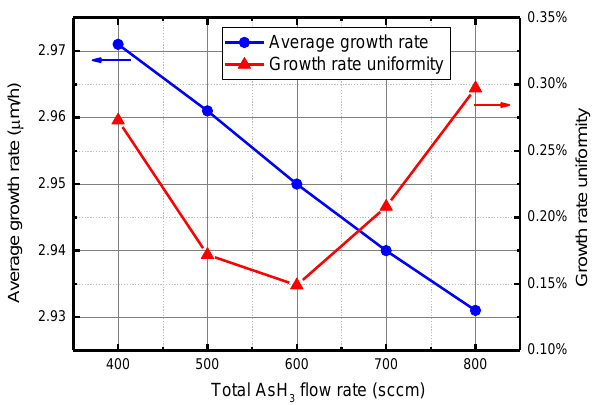
Figure 4. Simulated results of the average growth rate and growth rate uniformity as functions of the total AsH 3 flow rate. P = 5 × 10 3 Pa, T growth = 700 °C, carrier gas flow rate Q H2 = 37 slm.